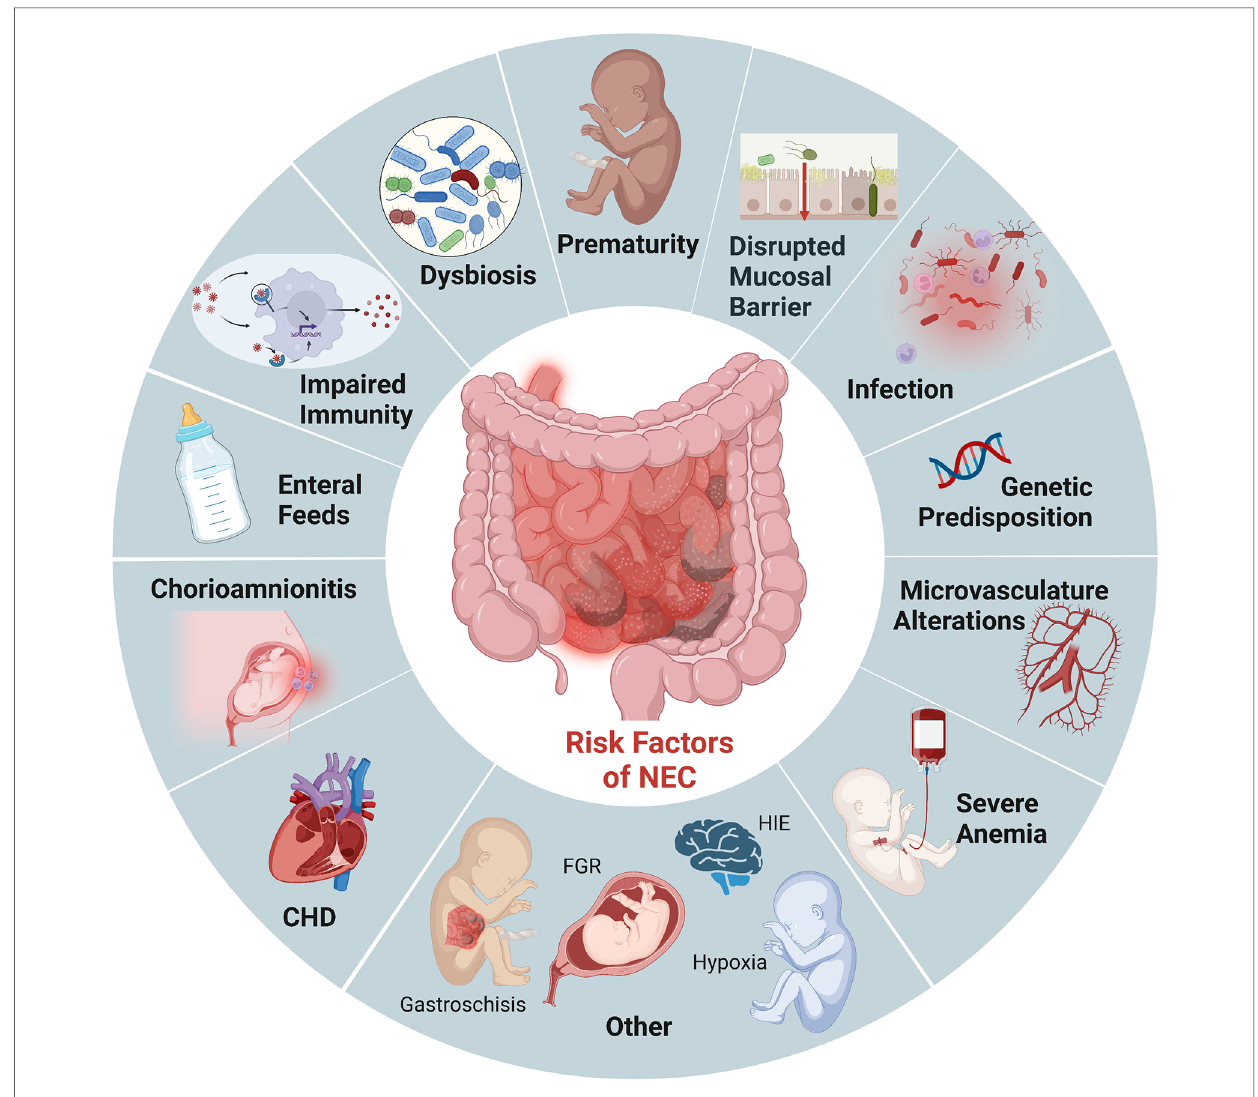
FIGURE 1 Established risk factors NEC. Illustration created with